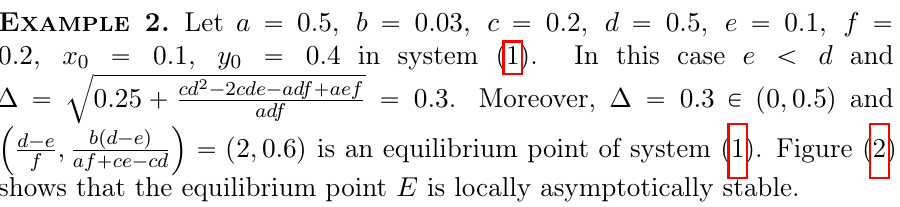
, y n ` 1 “ 2 ` 0 . 3 y n